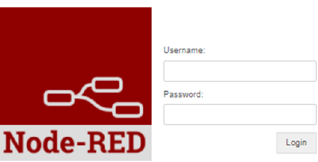
Figure 3. Node-RED network security authentication.